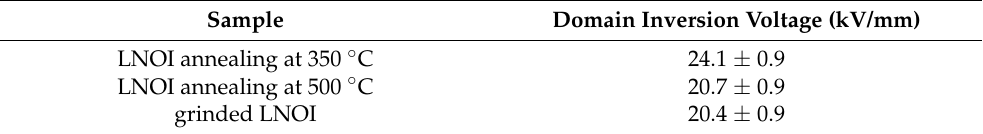
Table 1. The domain inversion voltage of LNOI.